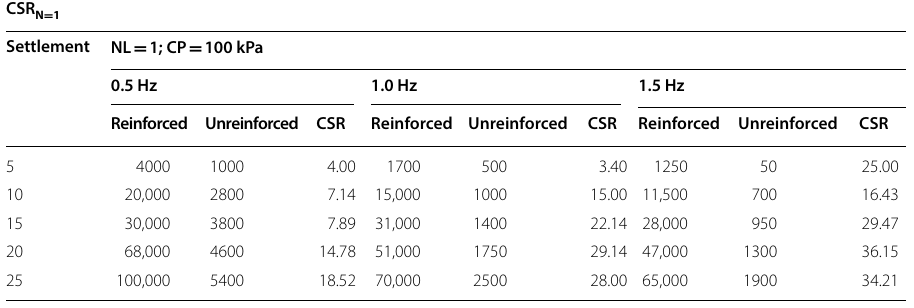
Table 4 CSR values for NL CSR N = 1 Settlement NL